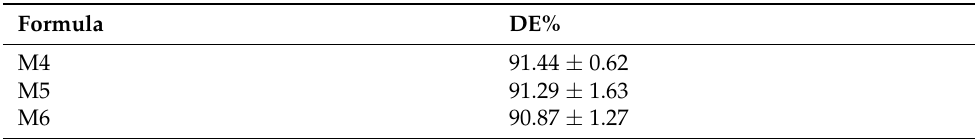
Table 1. DE% Drug entrapment efficiency of the drug-loaded pellets.